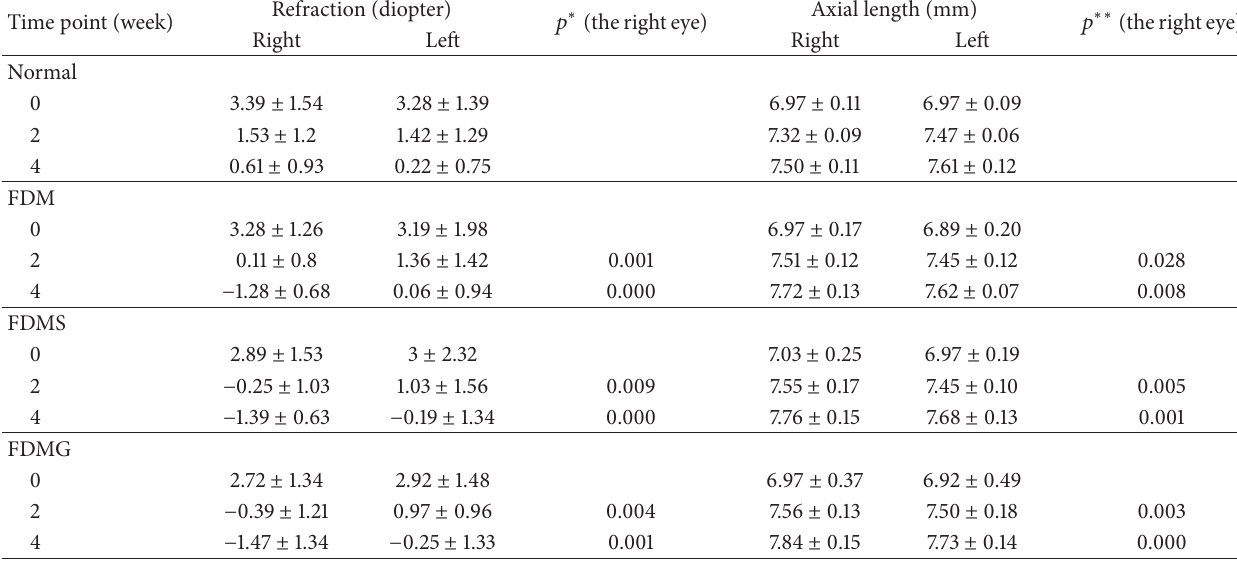
Table 1: Biometric results of all the four groups (mean ± SD) and the comparison of refraction and axial length between FDM, FDMS, FDMG, and normal control group, respectively (one-way ANOVA with Bonferroni correction).